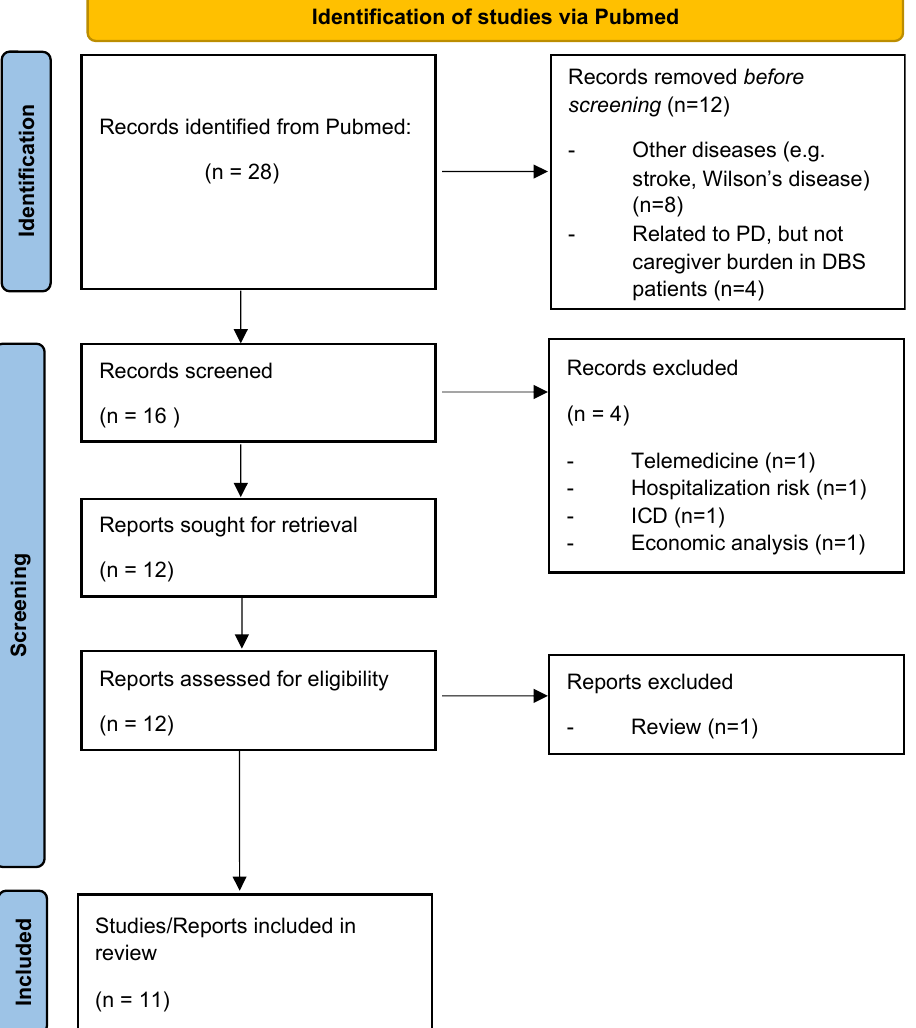
Figure 1. Flow diagram for search of PubMed database with the search terms “Caregiver Burden” and “Deep Brain Stimulation” or “DBS”.